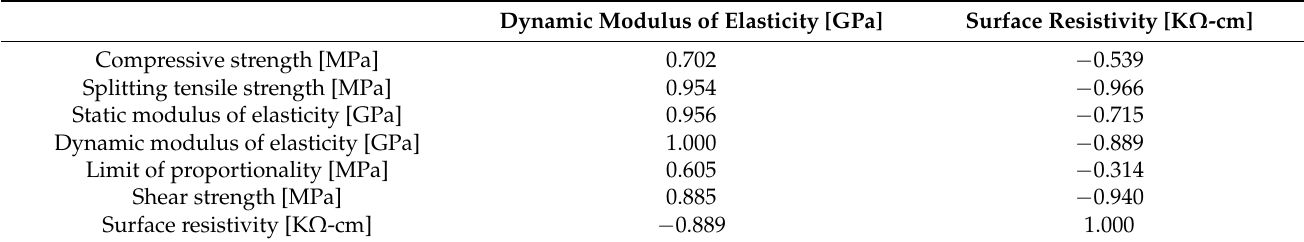
Table 2. Pearson correlation coefficients between the two parameters of non-destructive testing methods (NDTs) and other destructive testing methods